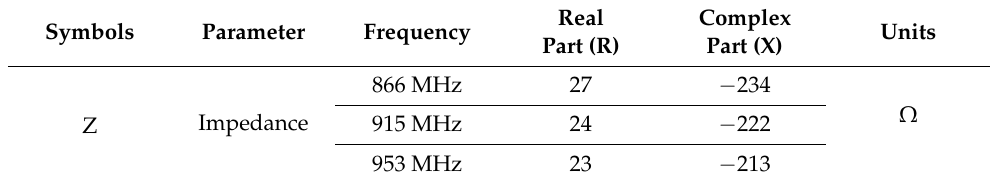
Table 2. SL3S1003 chip Input